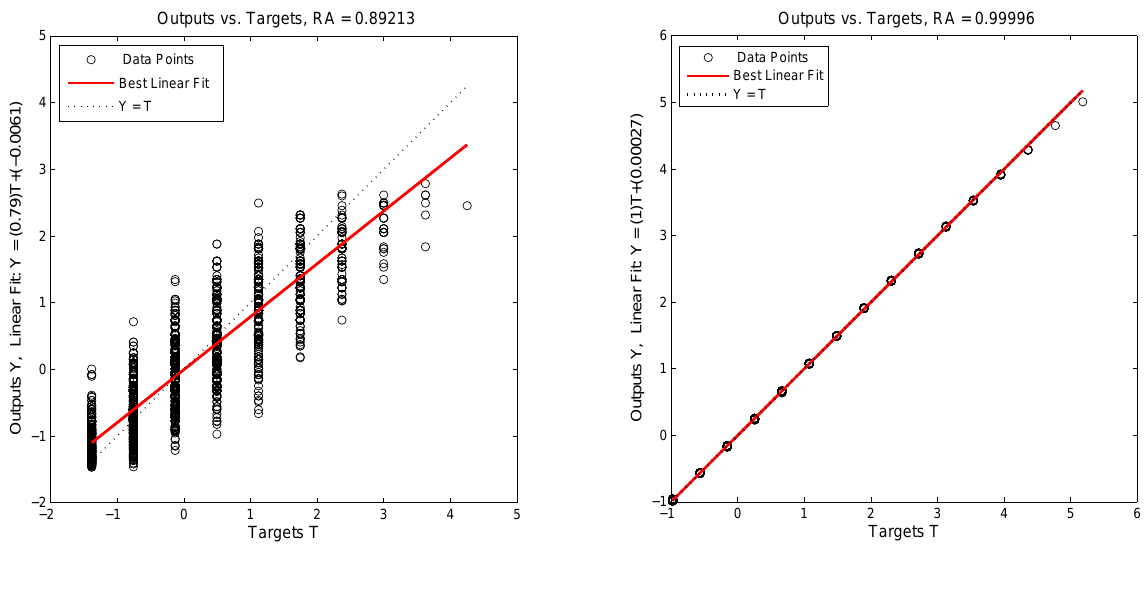
Figure 14. The regression analysis between the network response and the corresponding targets: 1-hop regression analysis (left) and 2-hop regression analysis (right).